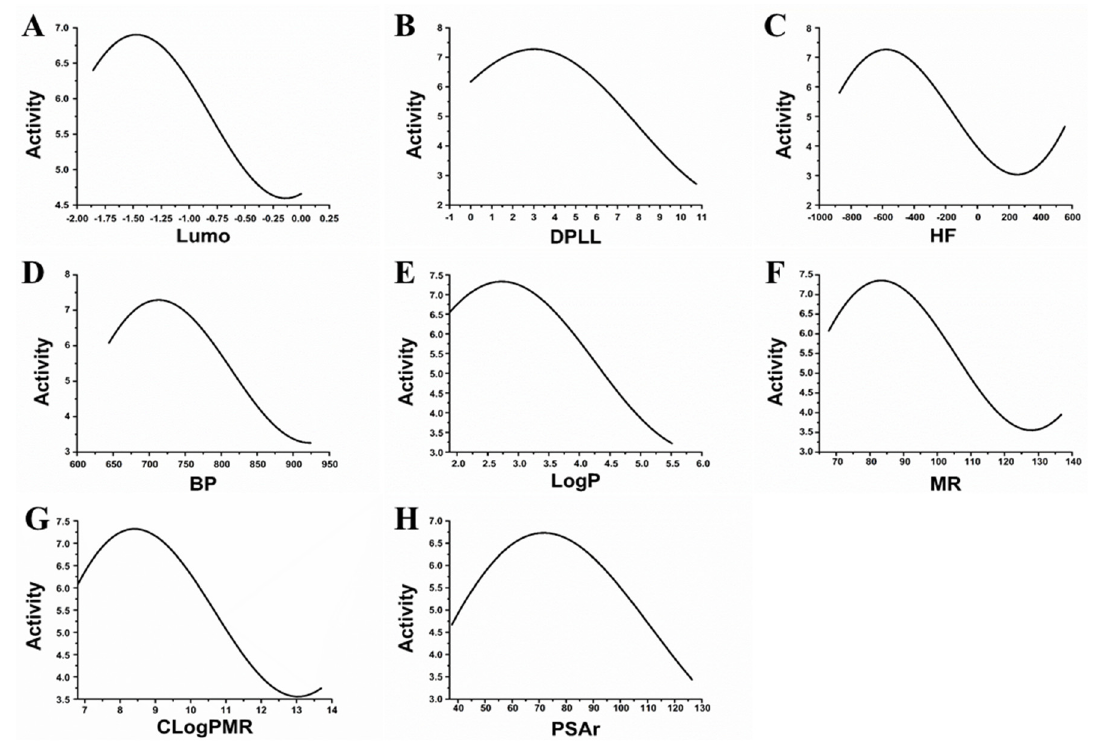
Figure 1. The relationship of activity of different molecule descriptors. Table 1. The results of the prediction accuracy with eight molecular descriptors using different ma- chine learning methods.